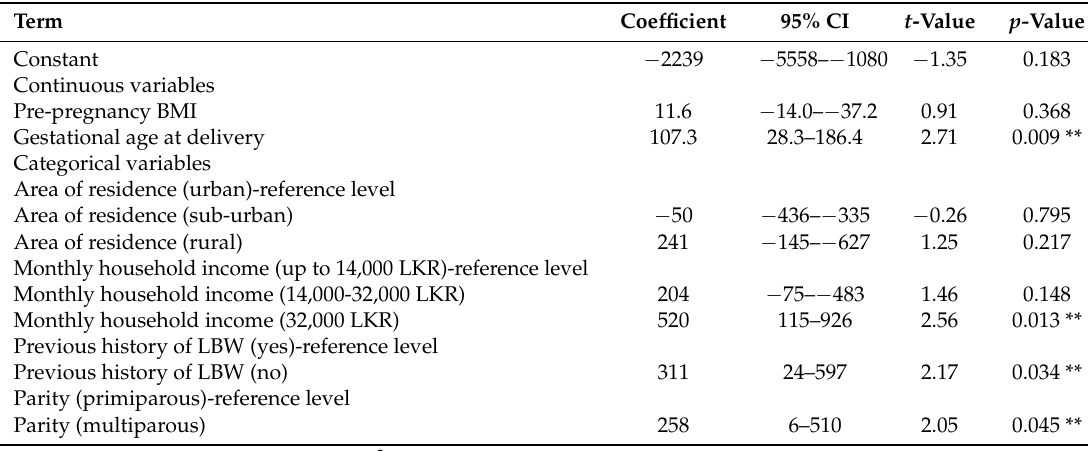
Table 2. Effects of maternal parameters on neonatal birth weight, multiple regression model for neonatal birth weight